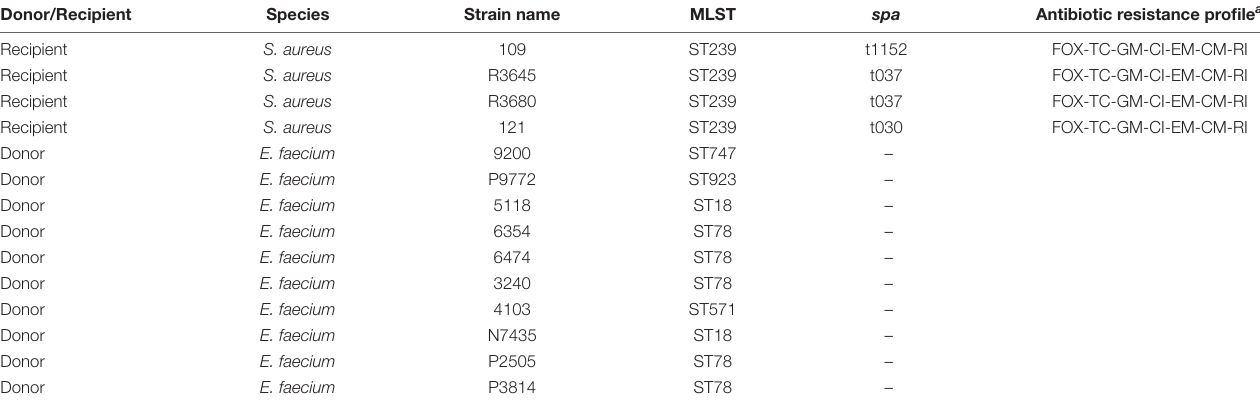
TABLE 1 | Background of donor and recipient strains.